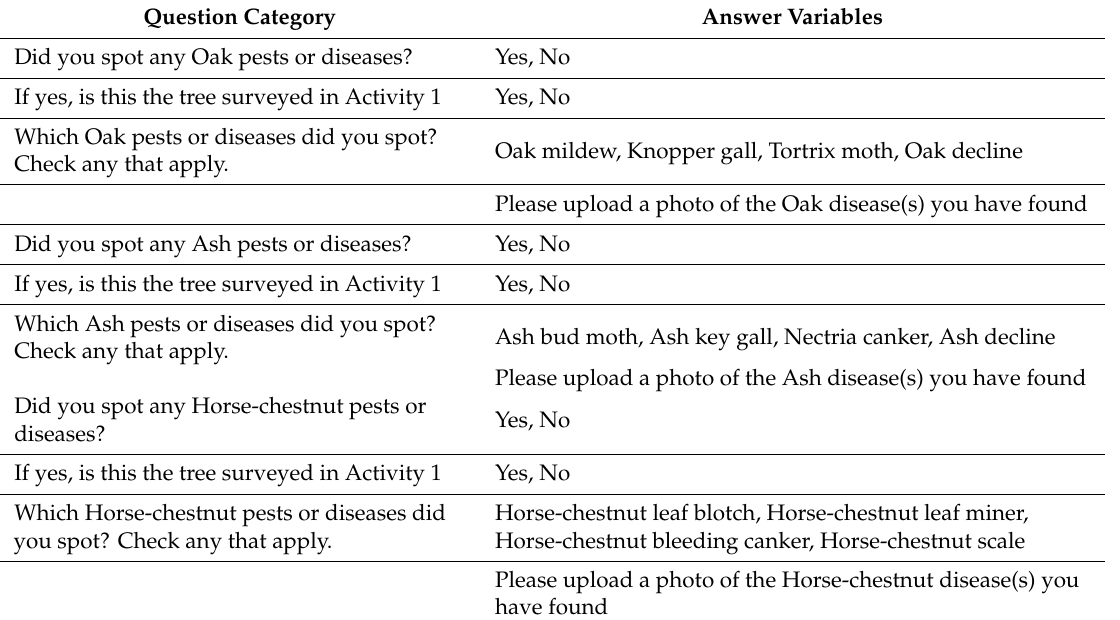
Table 3. Summarised recorded variables for Activity 2, “Pests and